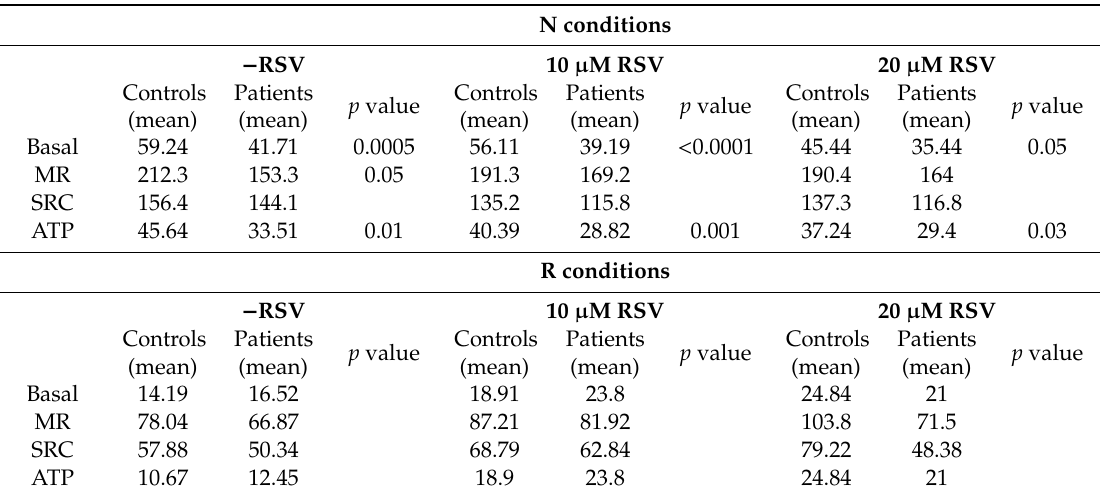
Table 3. Comparison of the mean values of the key parameters for mitochondrial function (basal, MR, ATP production and SRC) using a Seahorse XF96 Cell Analyzer in myoblasts between patients (n = 5) and controls (n = 5) under normal (N) or restricted (R) conditions. p values are only shown in the case of significant di ff erences between patients and controls. − RSV = without RSV.